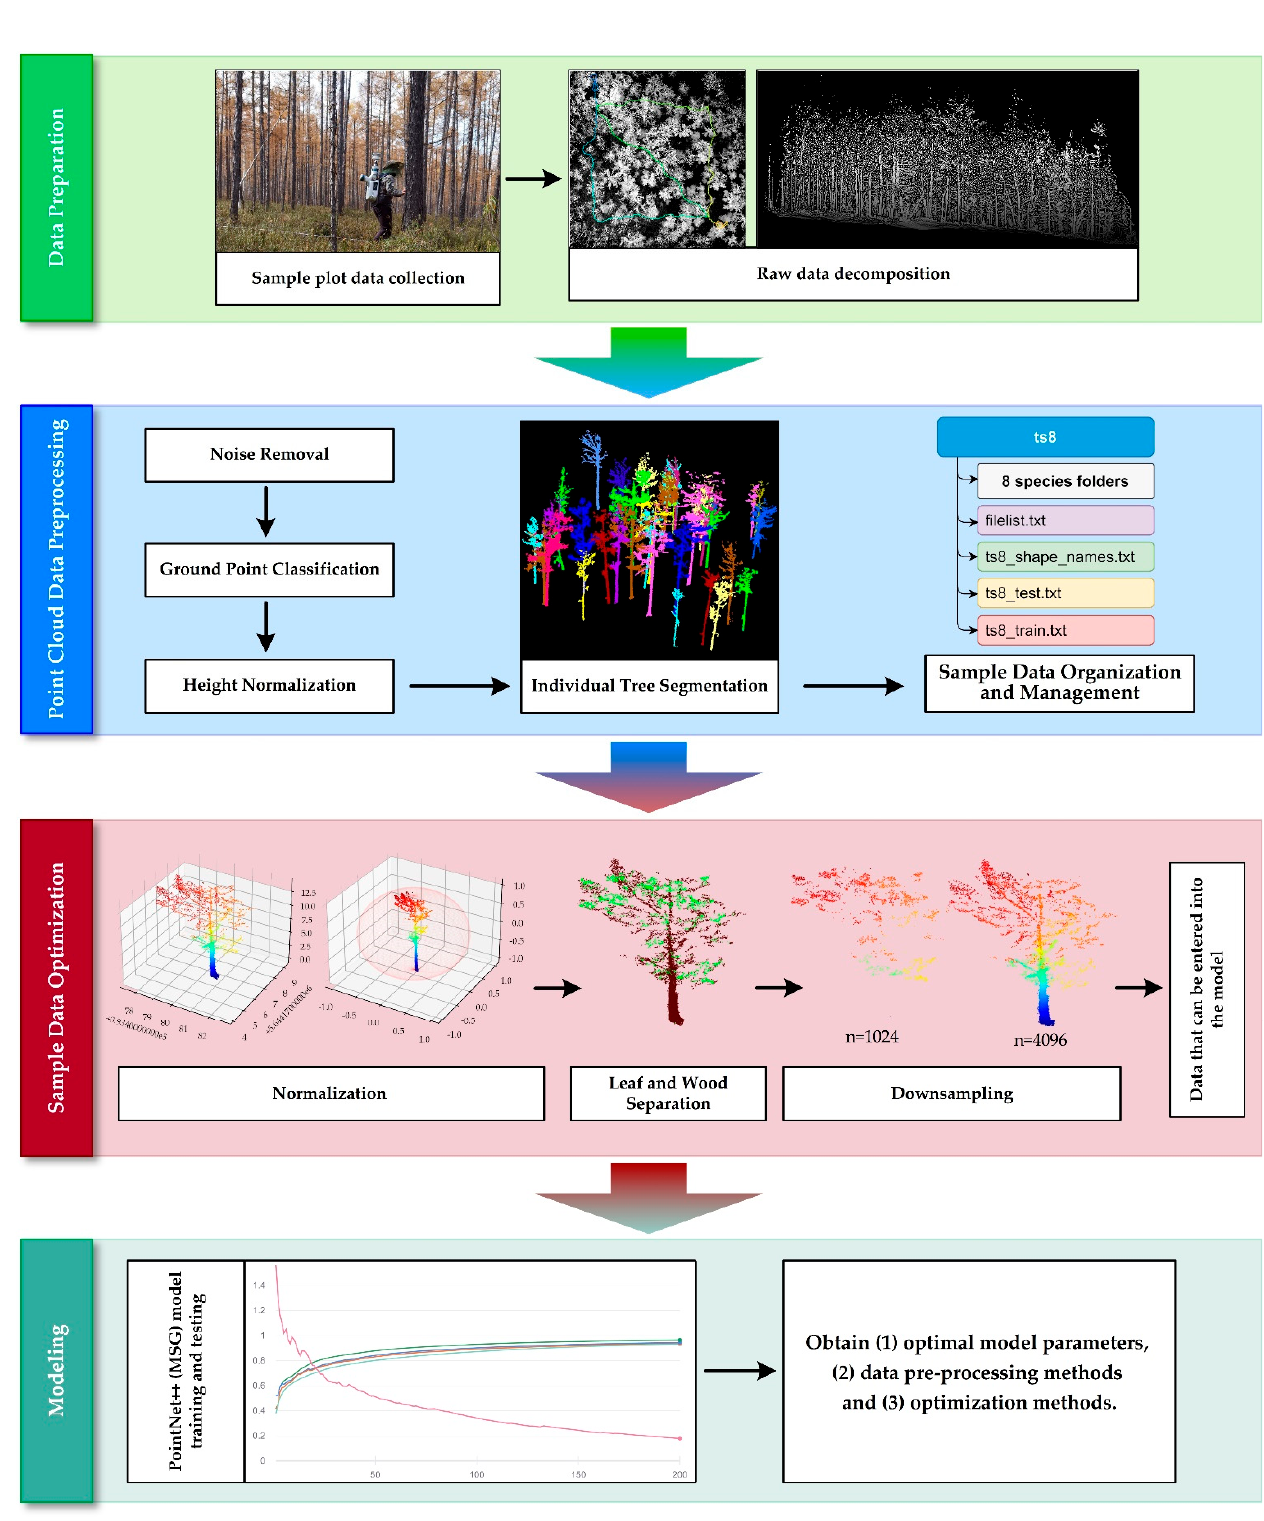
Figure 2. The complete experimental procedure consisting of four